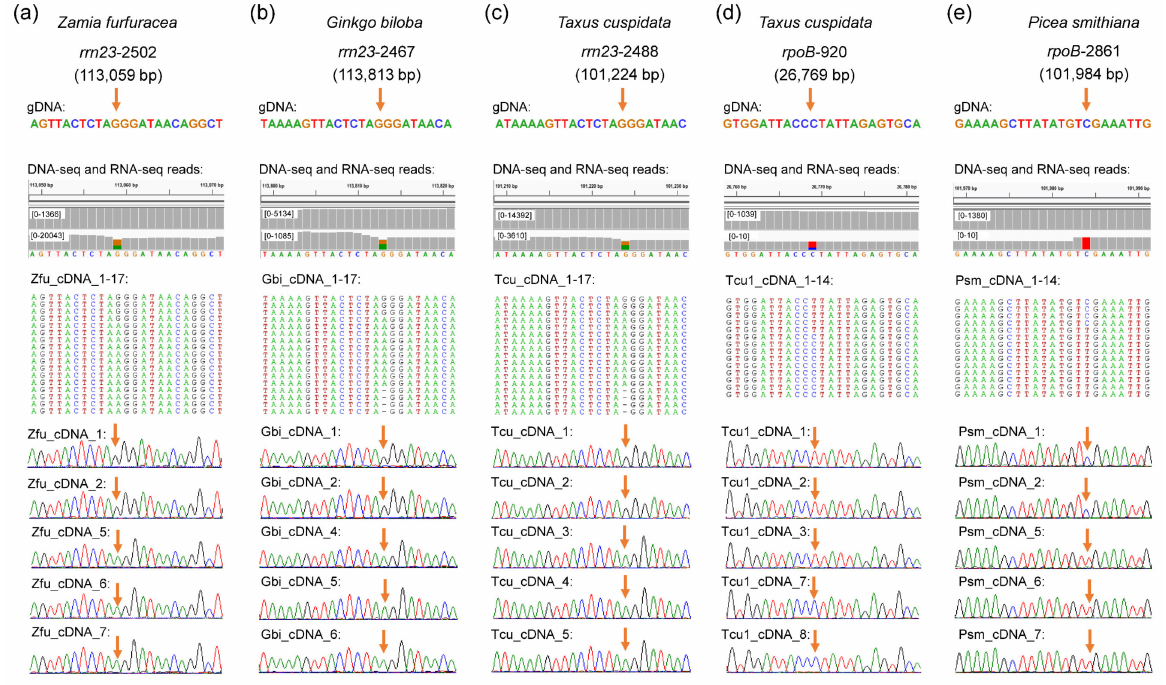
Figure 1. Examples of identification and validation of G-to-A and C-to-U RNA editing sites. The left three panels represent G-to-A RNA editing sites ( a – c ), and the last two panels indicate C-to-U RNA editing sites with low RNA-seq read coverage ( d , e ). Editing sites are indicated by arrows. From top to bottom shows species name; genic and plastomic positions of RNA editing sites; RNA editing sites and their upstream and downstream sequences; the mapping of DNA-seq and RNA-Seq data on plastomes, numbers on the left-top show read coverage; sequences of cDNA clones; and Sanger sequencing of some examples of cDNA